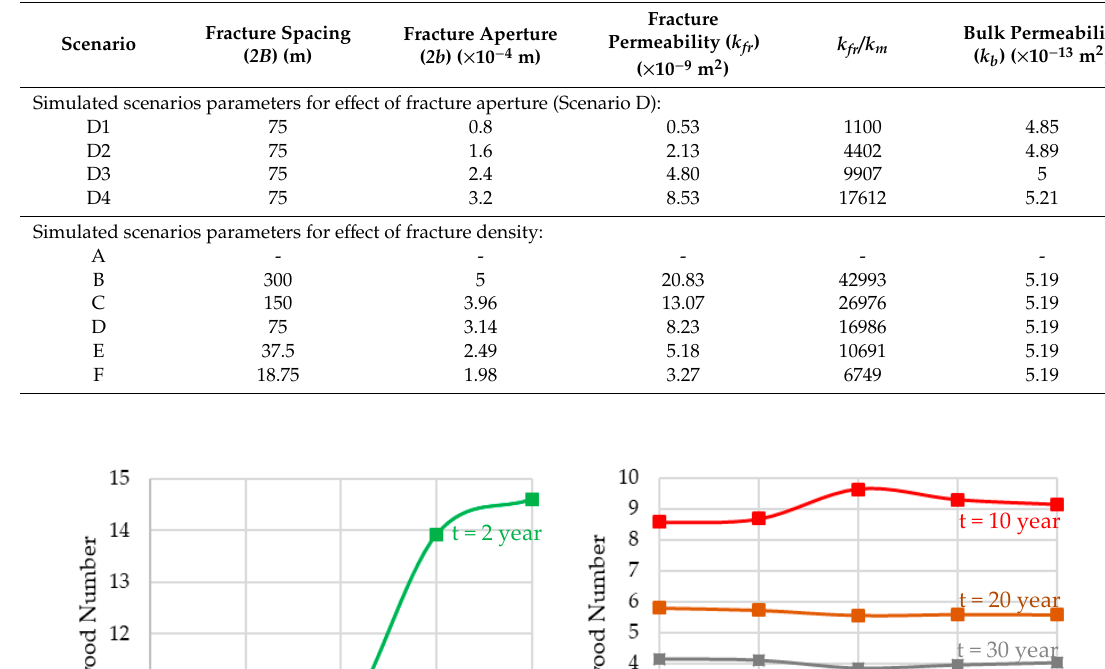
Table 2. Fractured network parameters.